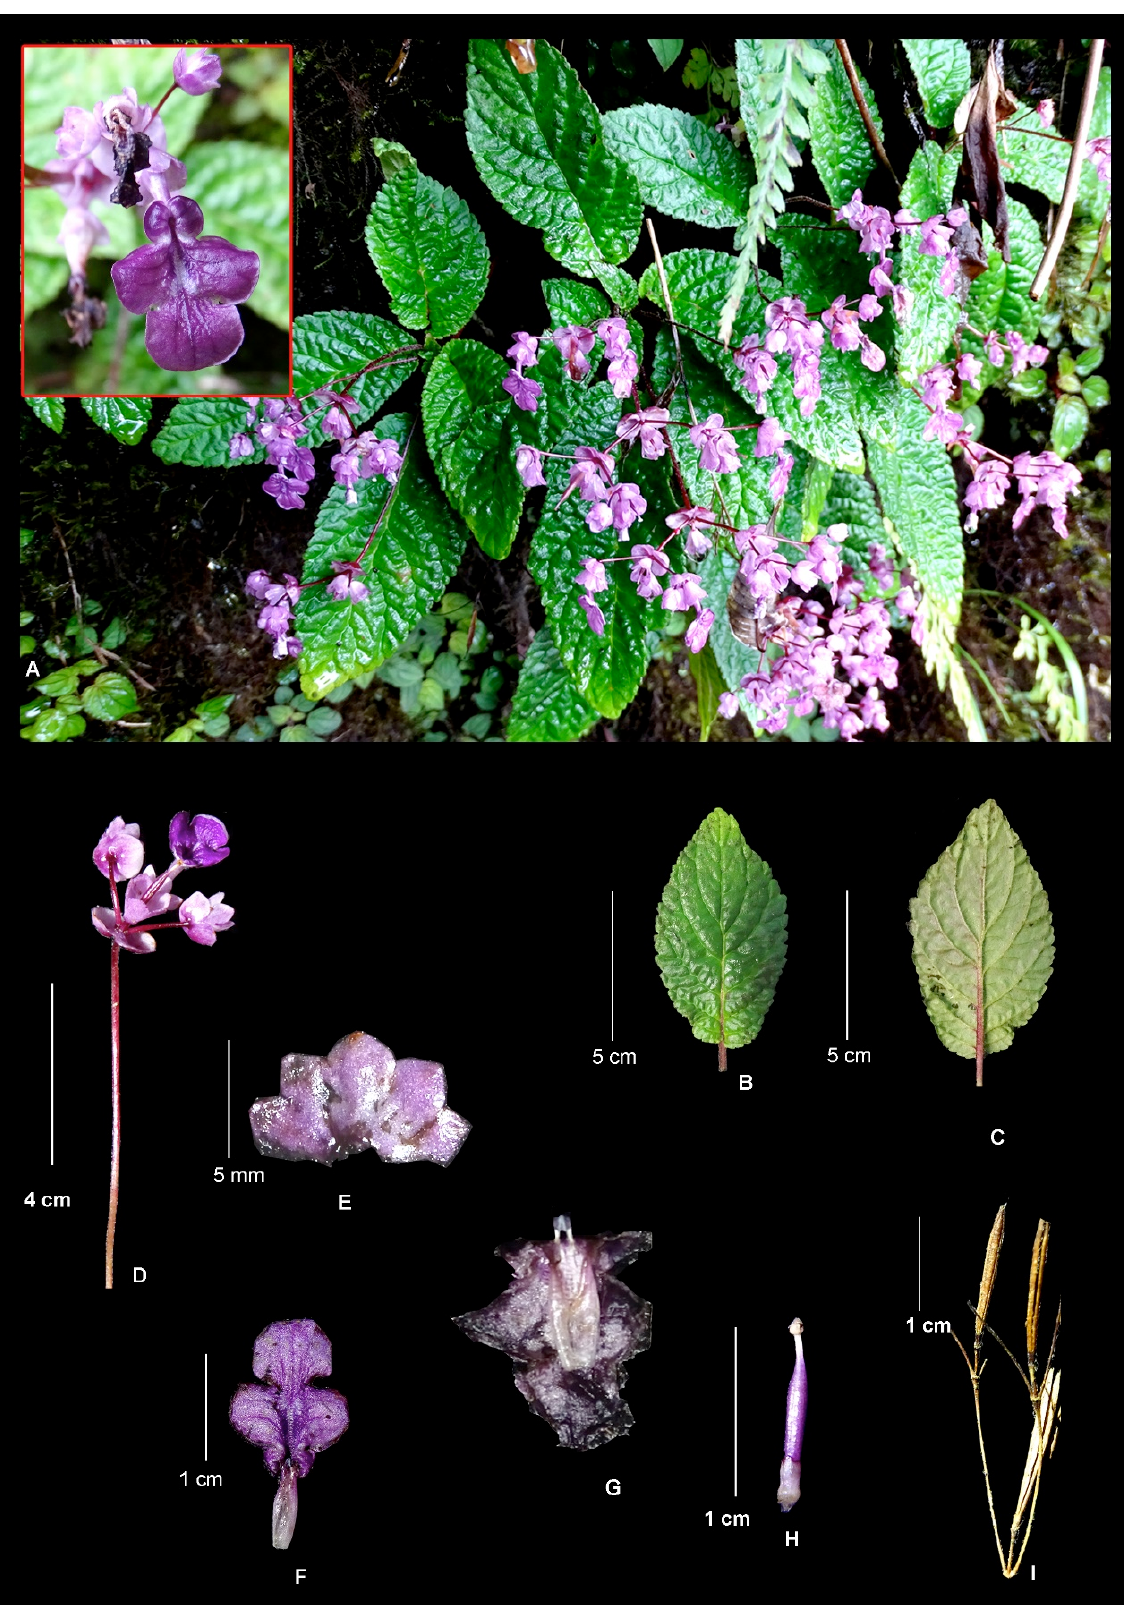
Image 1. Didymocarpus bhutanicus W.T. Wang: A—habitat | B_adaxial surface of leaf | C—abaxial surface of leaf | D—inflorescence | E—calyx | F—corolla | G—corolla split to show stamen | H—pistil | I—capsules. @ Subhajit